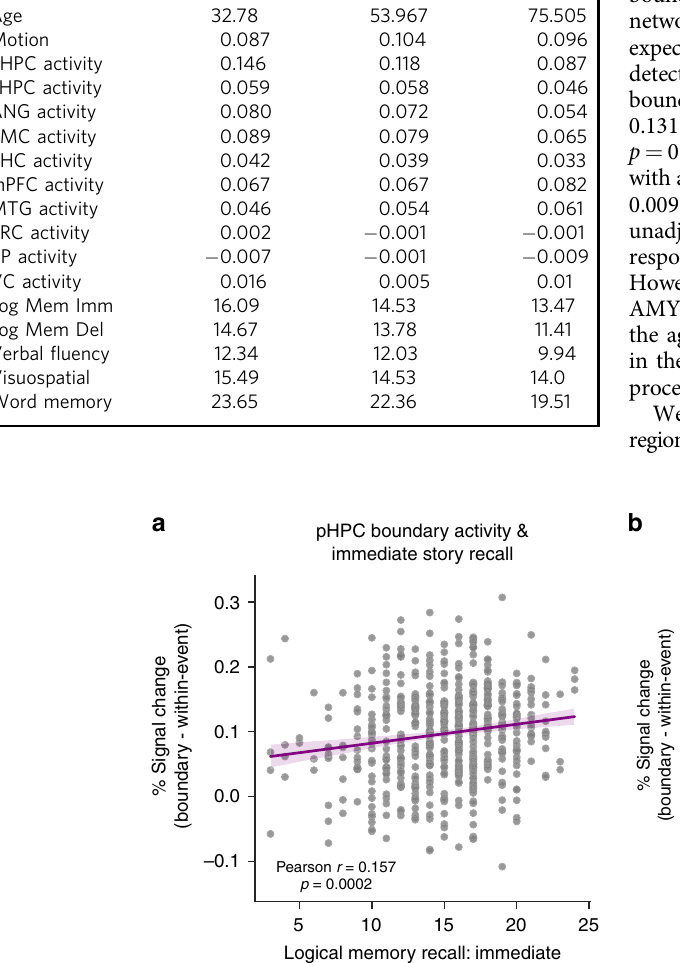
Table 1 Set of group averages for predictor variables entered into multiple linear regression analyses. Measure